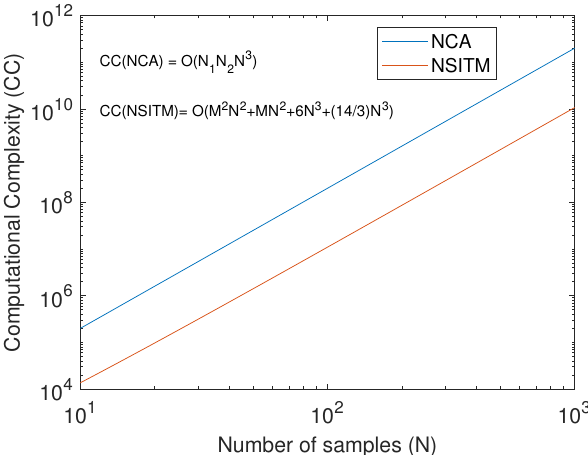
Figure 1. A logarithmic plot to illustrate a comparison between the computational complexity (CC) of NCA and NSITM, with the variations of number of samples (N), assuming N 1 = 20, N 2 = 10, and M =